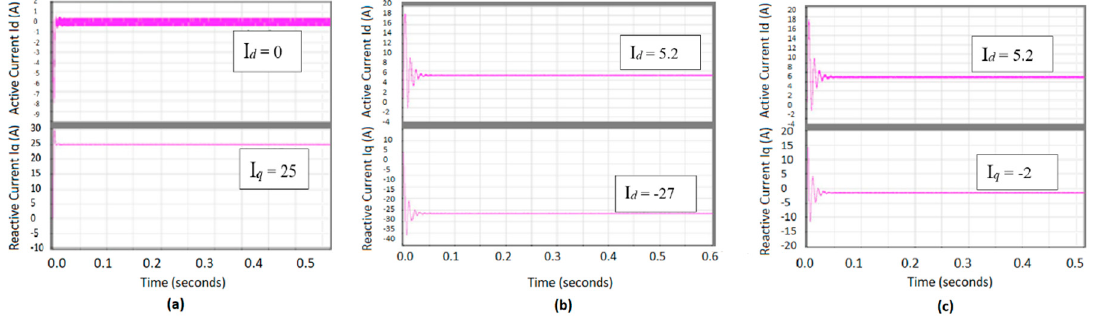
Figure 22. ( a ) the dq components of the injected RP for the loading scenario (L2); ( b ) the dq components of the distributed current for L2; ( c ) the dq components of the transferred current in the transmission lines for L2.